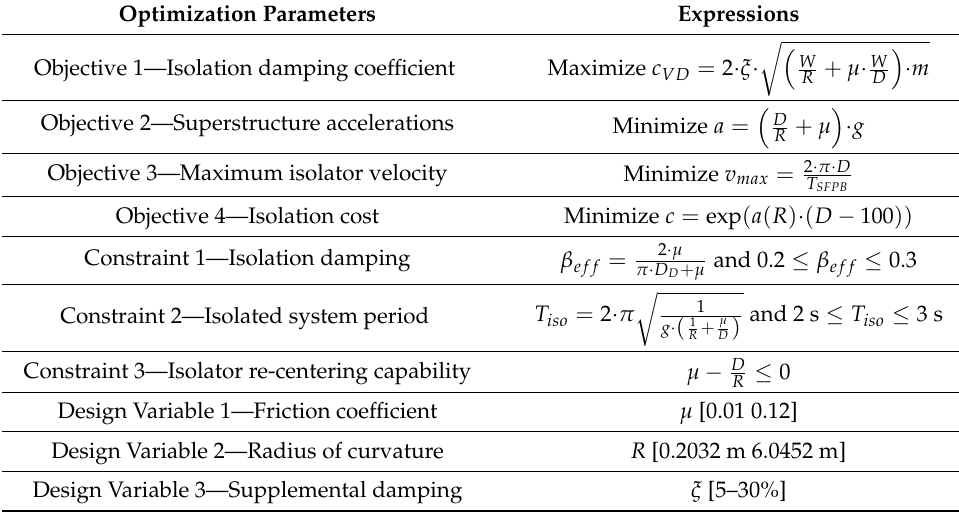
Table 2. Summary of optimization objectives, constraints, and design variables.